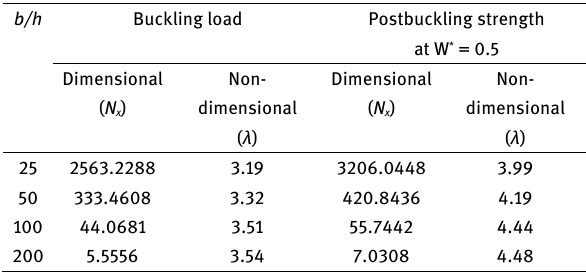
Table 8: Effect of b / h ratio on the buckling load and postbuckling strength of SSSS A-type FG-ESF-reinforced Mg nanocomposite plate.